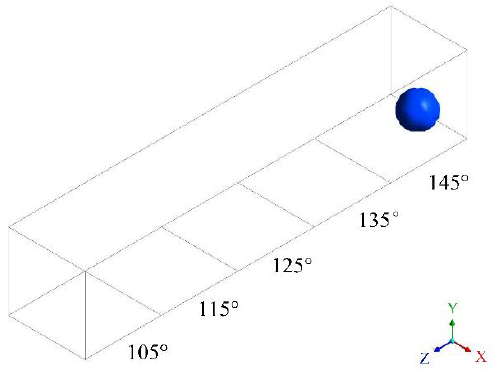
Figure 2. Modified GDL surface with varied static surface contact angle.